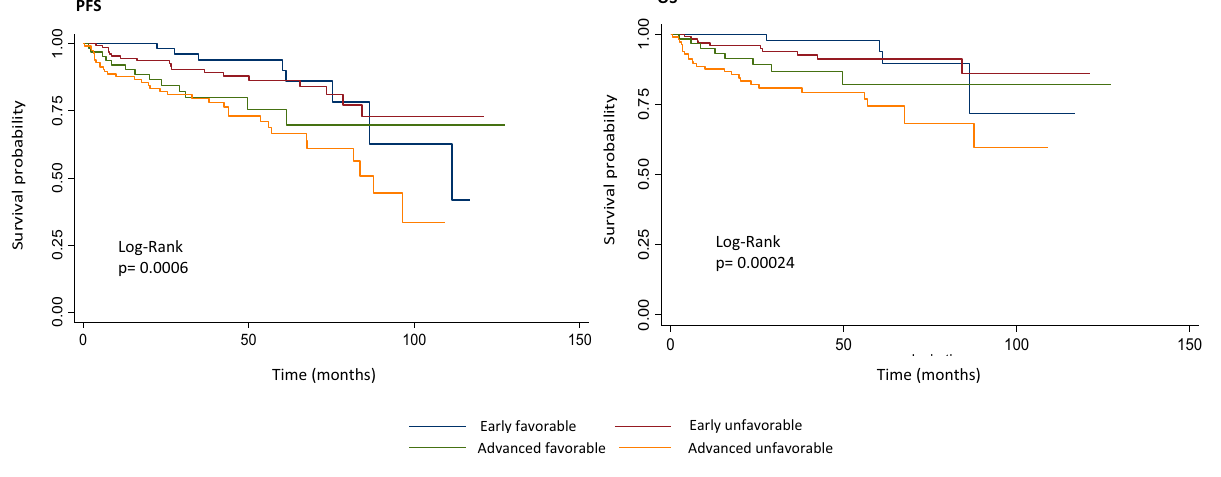
Fig. 1 Progression Free- and Overall Survival by risk group